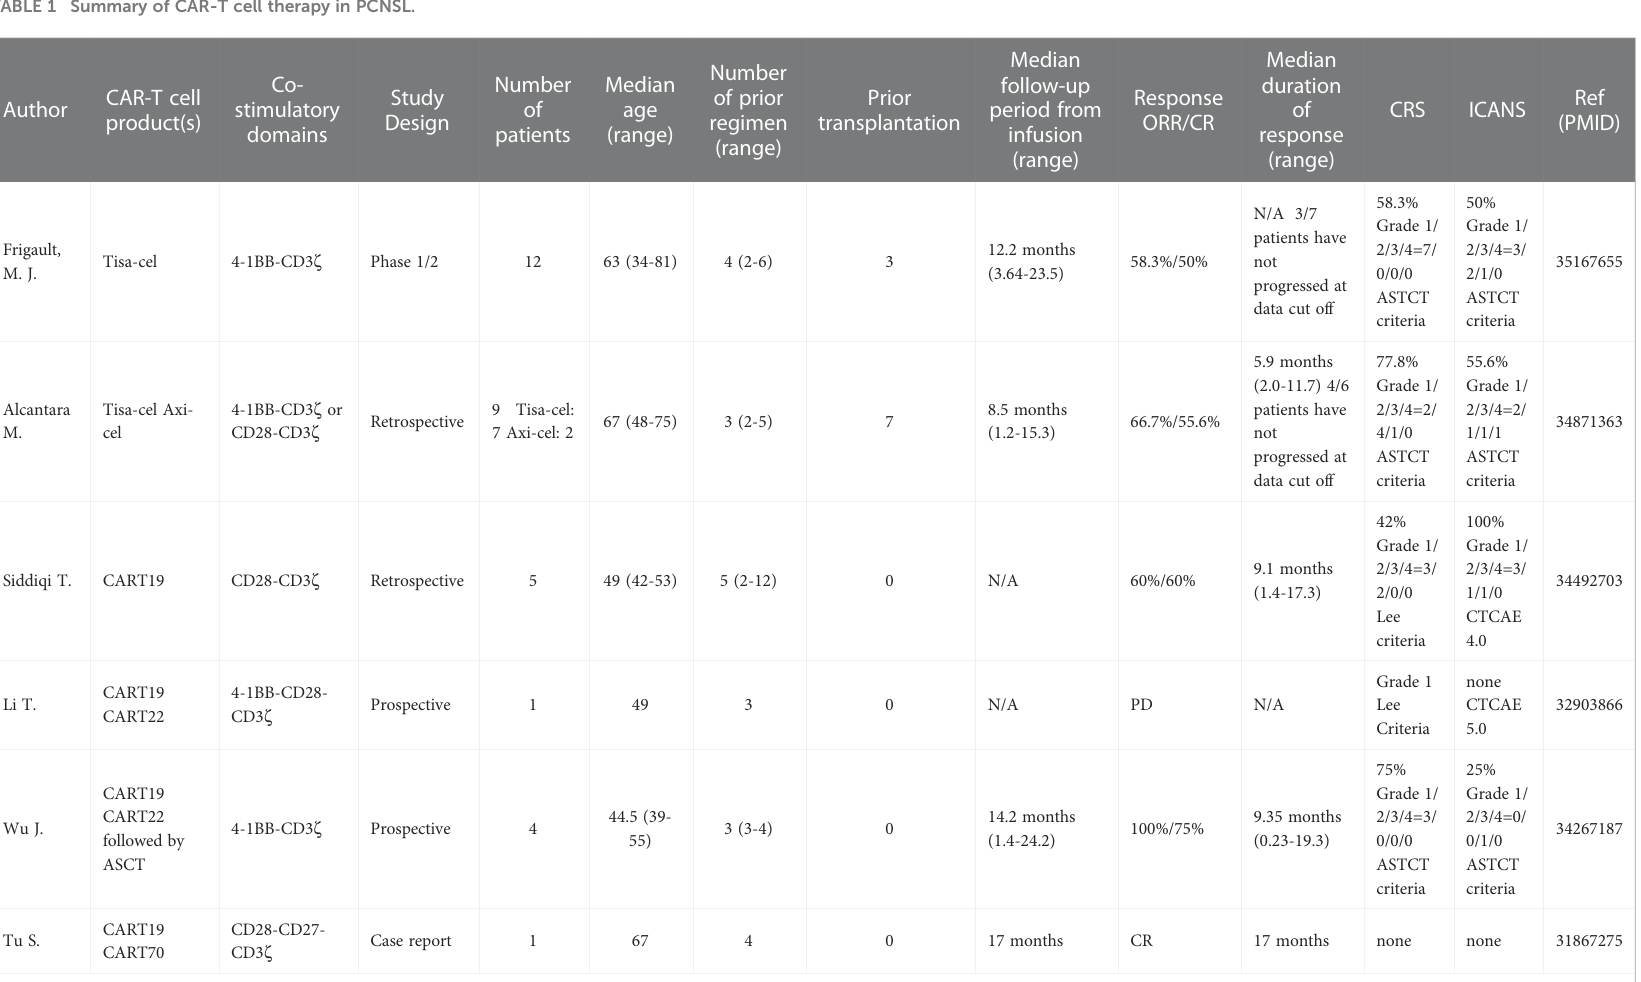
TABLE 1 Summary of CAR-T cell therapy in